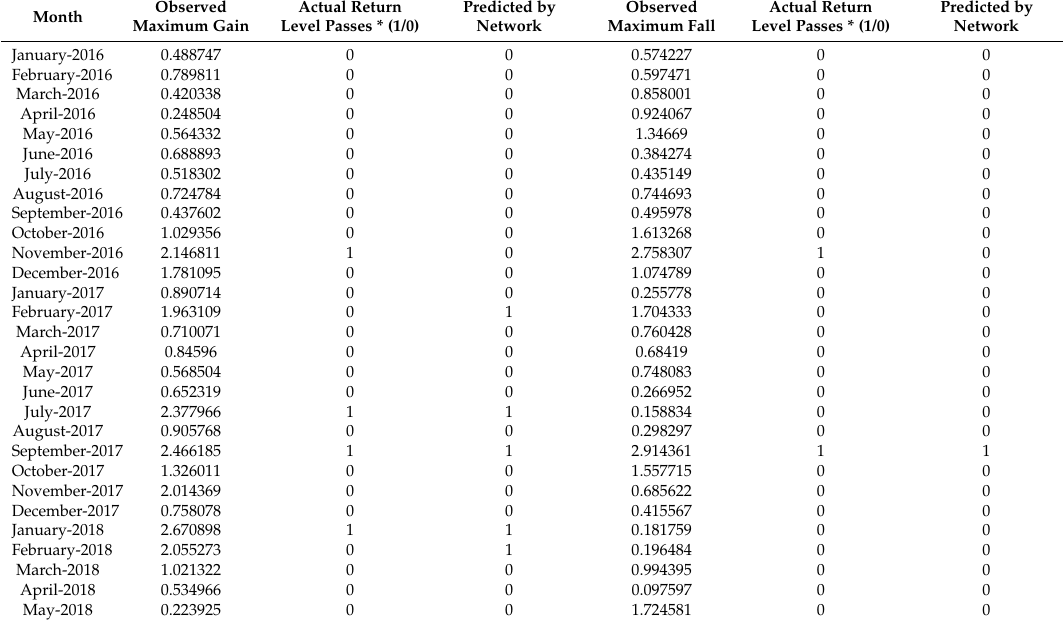
Table 9. Neural network predictions for maximum gains and fall for 2016, 2017 and 2018